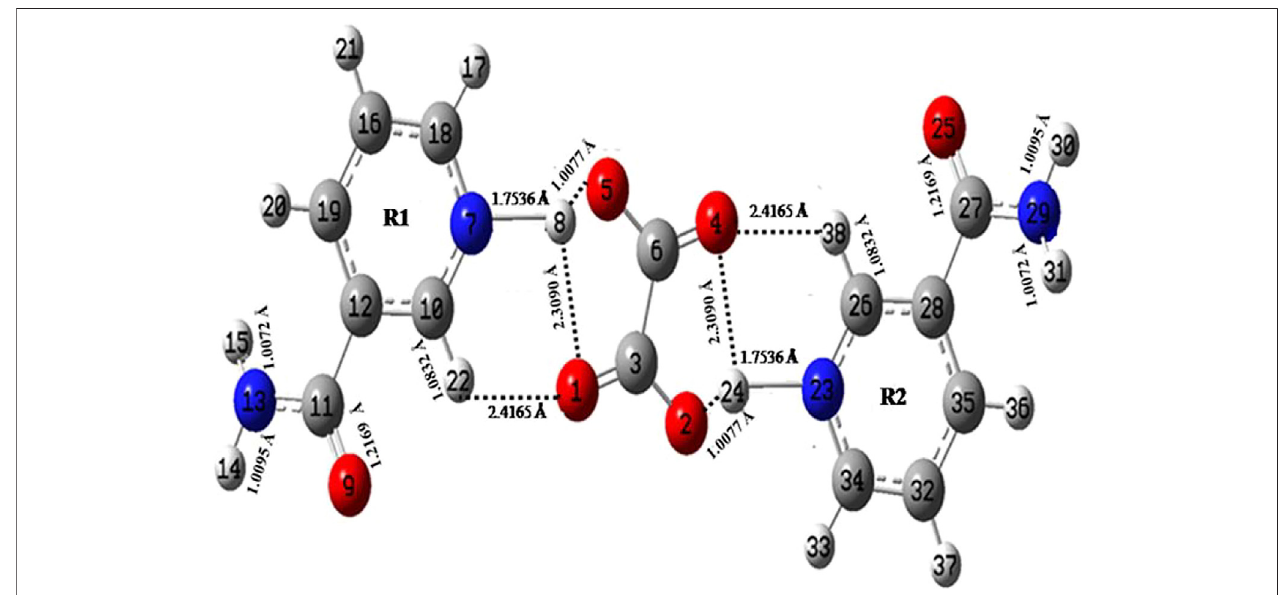
FIGURE 1 | Optimized structure of NIC – OXA salt with atom numbering adopted in this study. NIC – OXA, nicotinamide – oxalic acid.